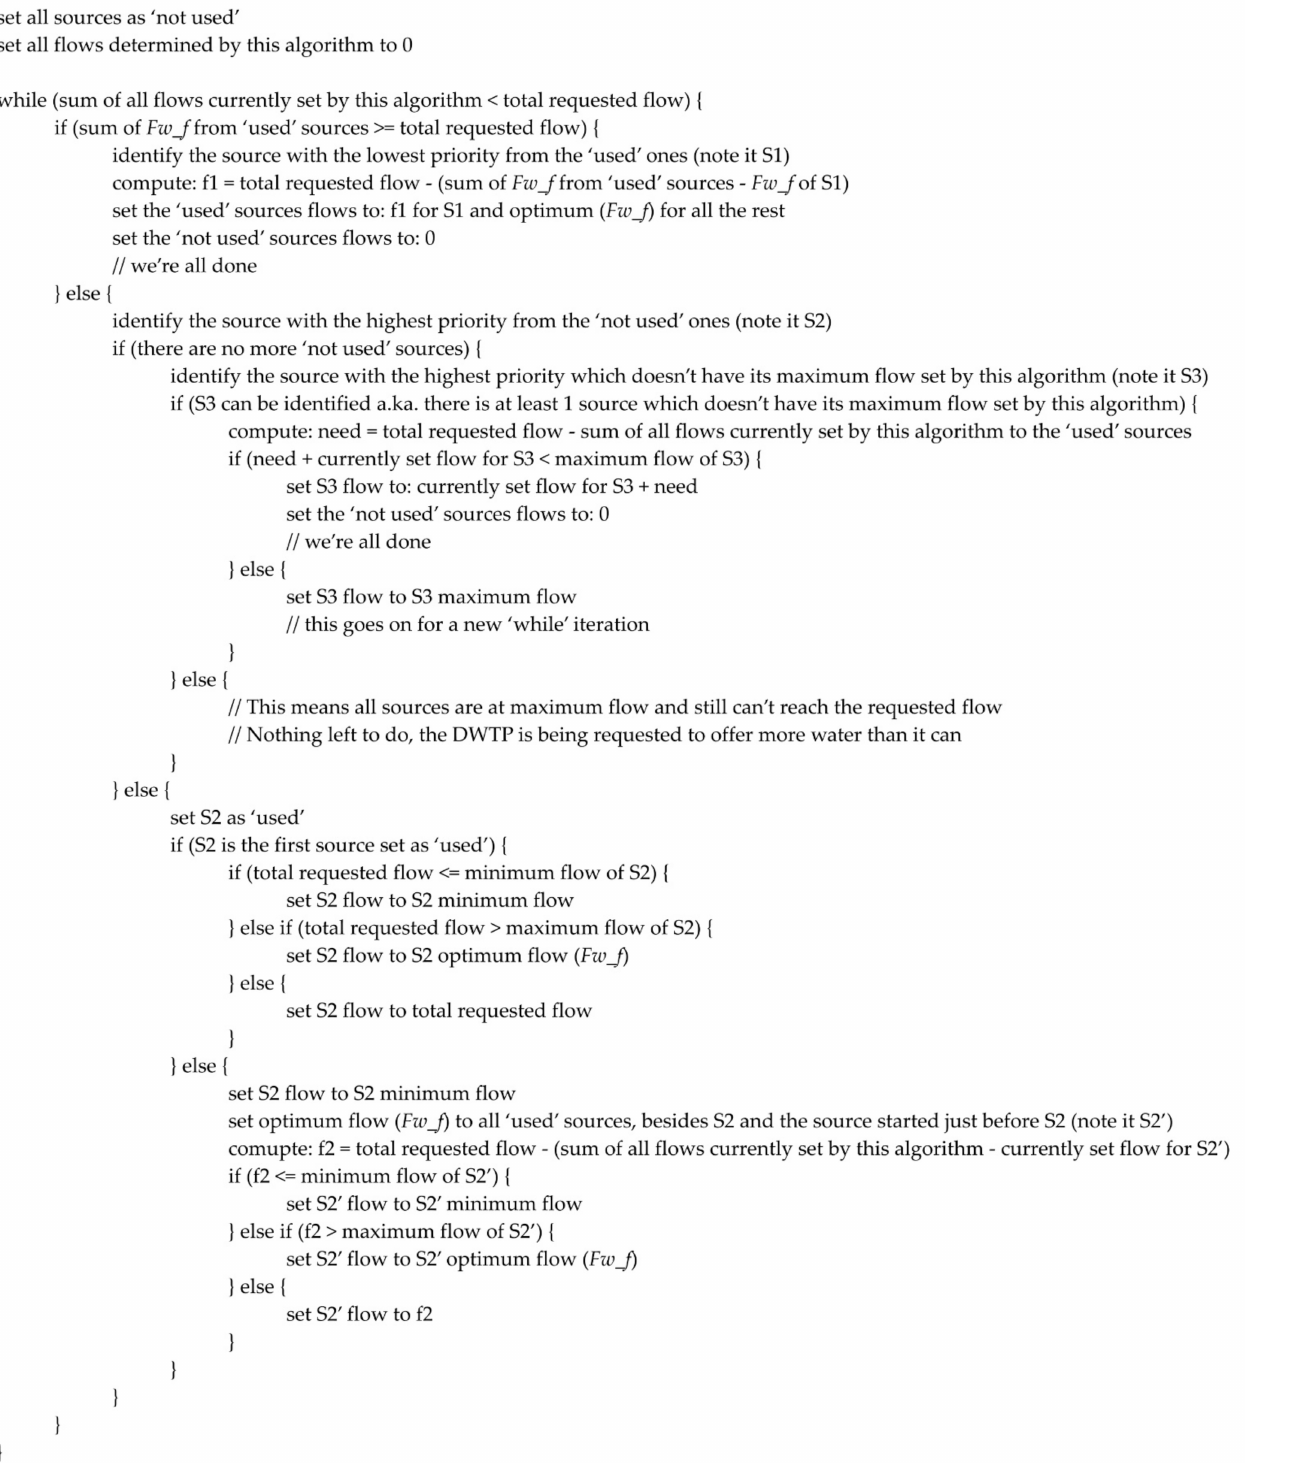
Figure 6. A high-level summary of the implemented algorithm for dividing the total requested water flow into specific flows for each source, in an optimum way for reducing energy